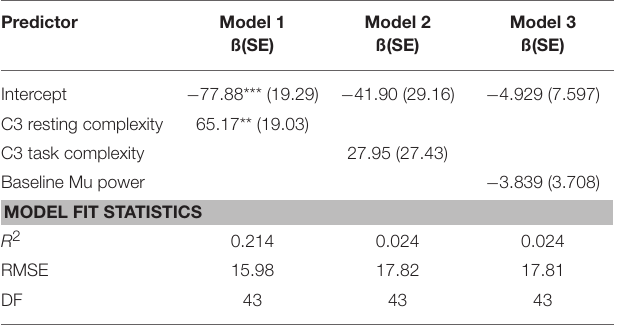
TABLE 1 | Parameter estimates, approximate p -values, and associated goodness-of-fit statistics for a series of models depicting the relationship between mu desynchronization scores (as an index of motor resonance) and complexity of the mu rhythm.